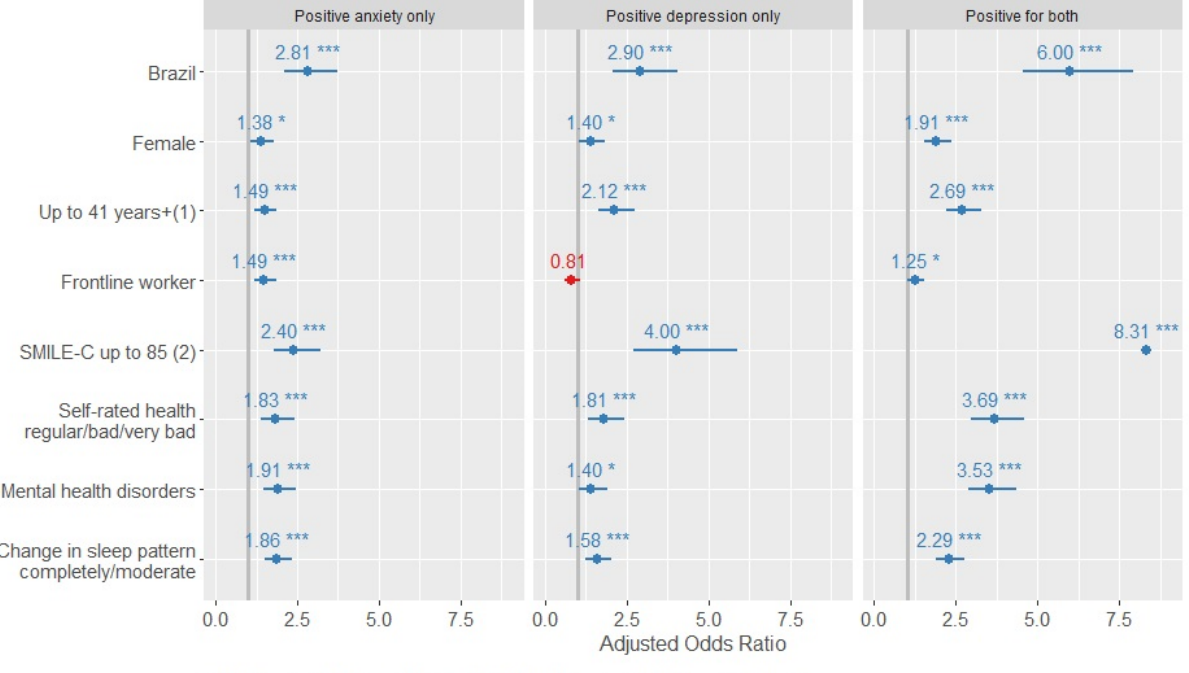
Figure 4. Factors associated with depression or anxiety or both (multinomial model) among essential workers from Brazil and Spain (n=3745). April-May, 2020. Note: (1) Age was dichotomized by the sample median age. (2) The SMILE-C (Short Multidimensional Inventory Lifestyle Evaluation-Confinement was dichotomized at the percentile 75%, the higher the score, the healthier the